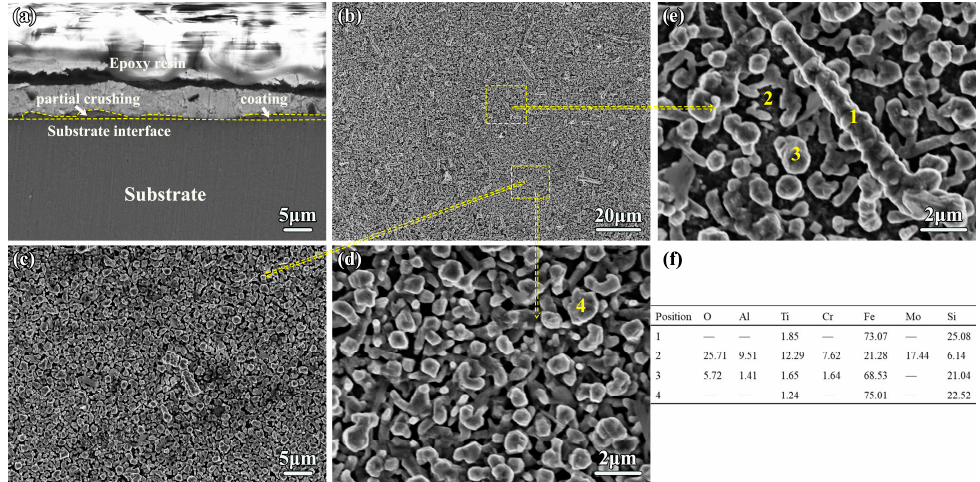
Figure 10. ( a ) SEM cross − sectional and ( b ) surface images of the T91 steel substrate at 550 °C for 2000 h.